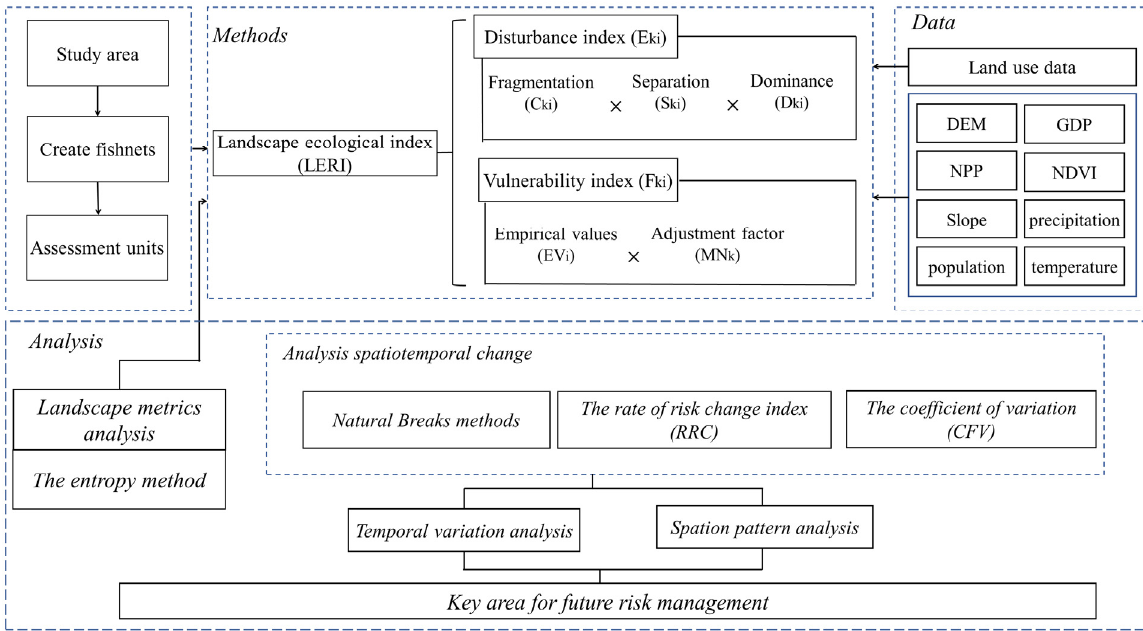
Figure 2. An analytical framework based on an improved ecological risk in the landscape.